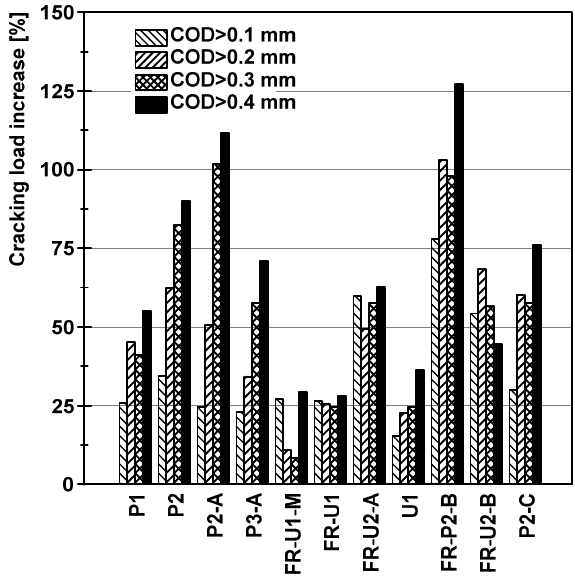
Figure 8. Increase in cracking